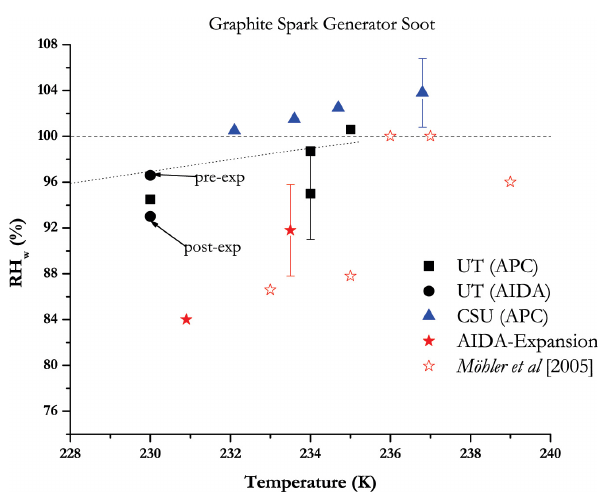
Fig. 7. Same as Fig. 5 but for graphite spark generator soot. Ice- saturation line not applicable for presented scale. Pre-exp and post- exp indicate sampling from the AIDA chamber before and after a cloud expansion experiment,